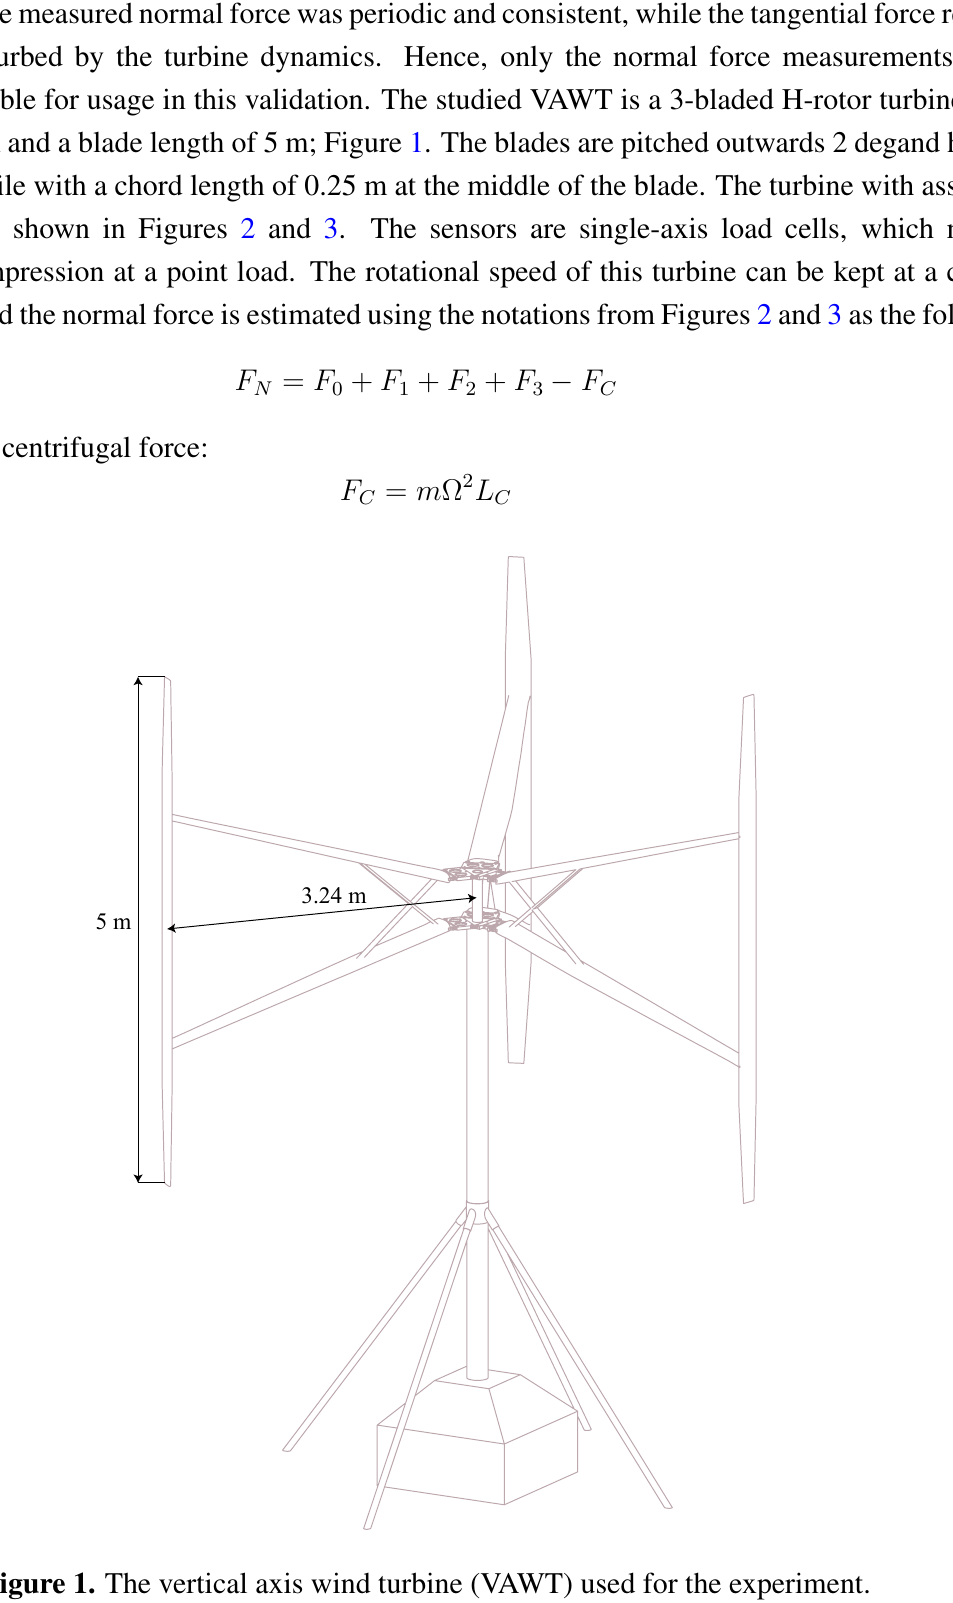
Figure 1. The vertical axis wind turbine (VAWT) used for the